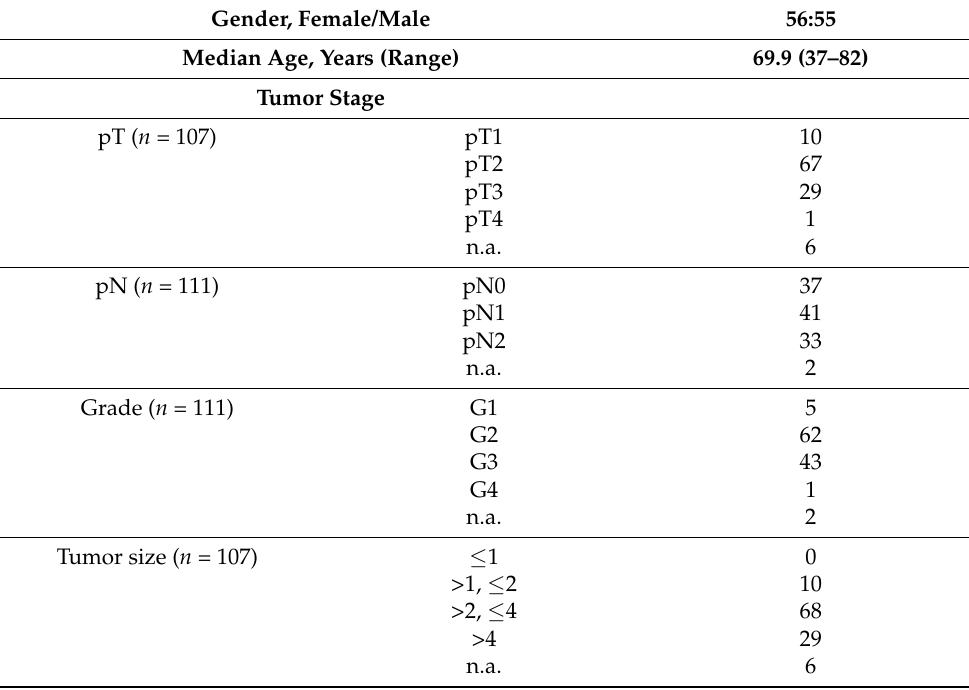
Table 1. Characteristics of included PDAC/PanIN patients.